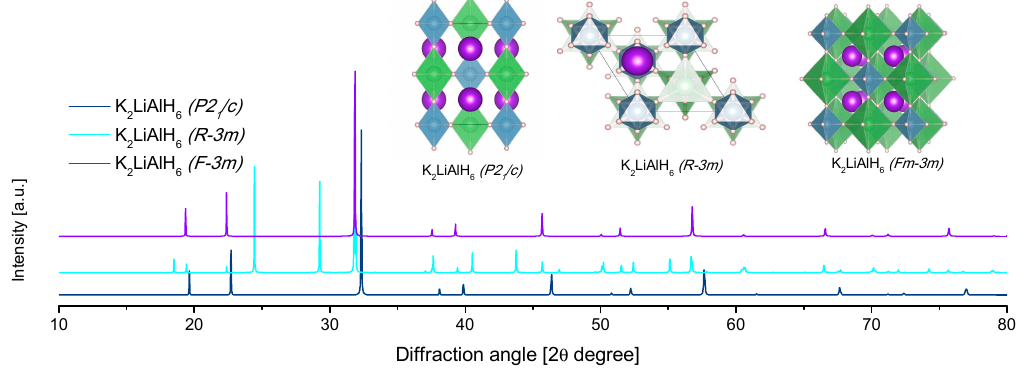
Figure 23. Crystal structure of Li-K alanate and its calculated diffraction patterns ( λ = Cu k α 1 ).